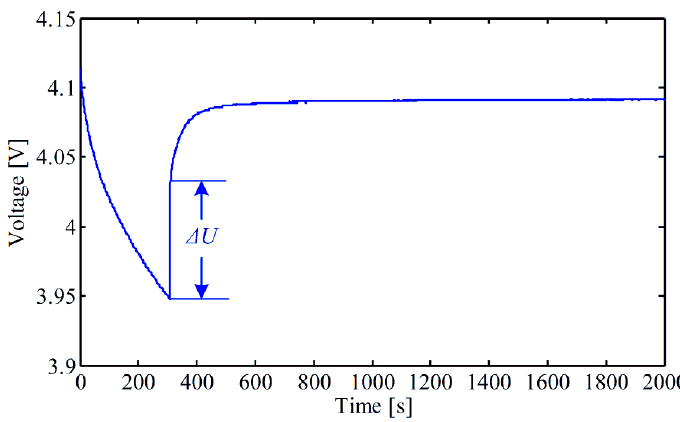
Figure 3. Transient response of terminal